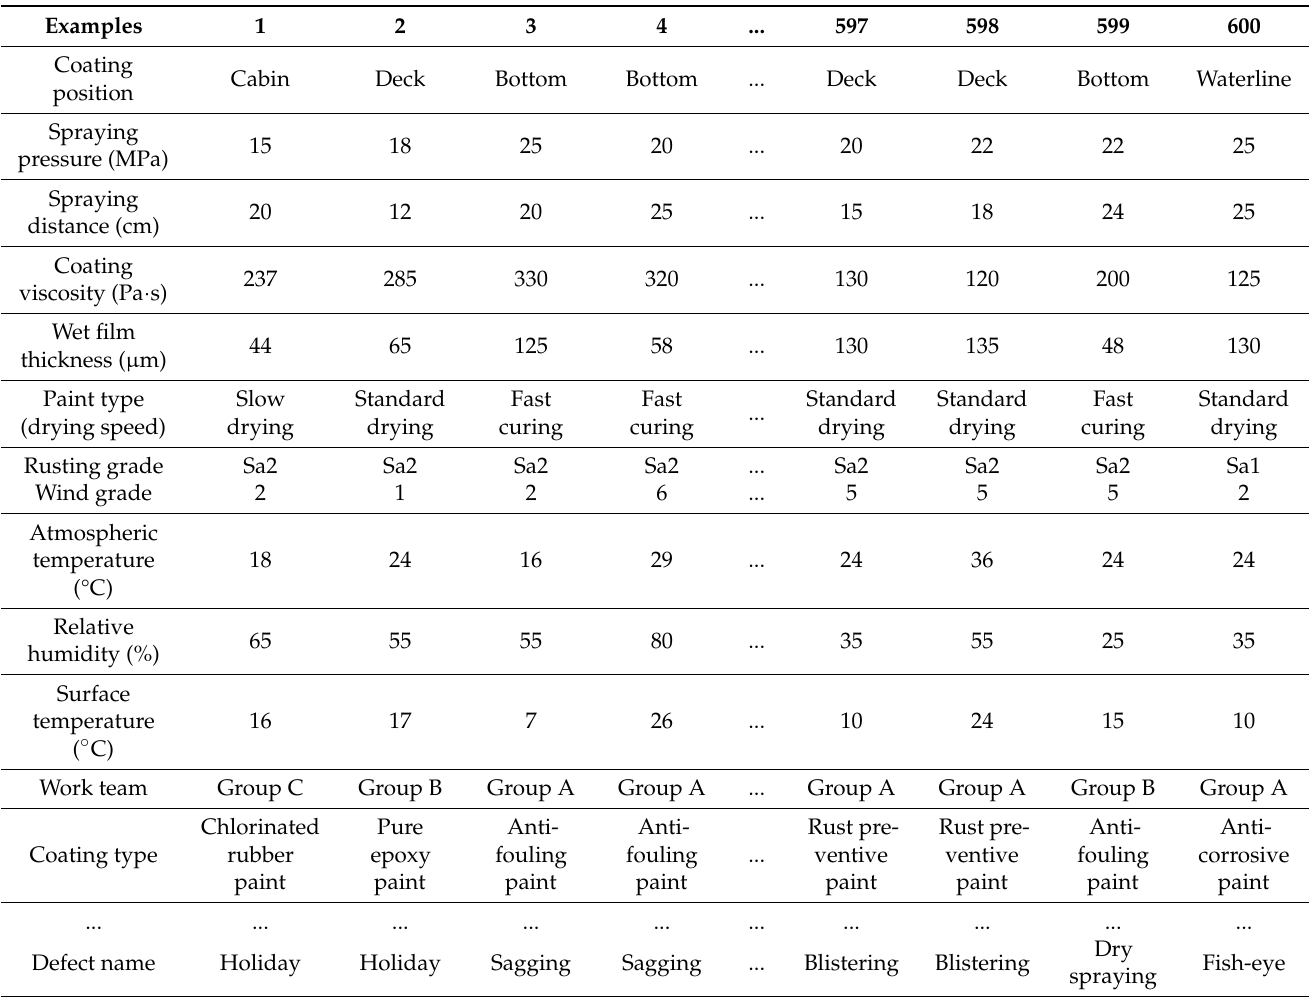
Table 1. Example data of ship coating defects.